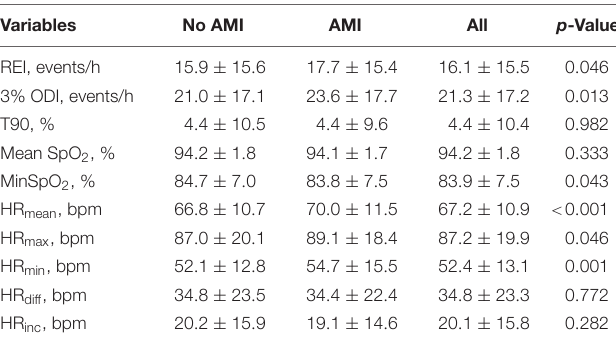
TABLE 2 | Sleep respiratory parameters and minSpO 2 -specific HR metrics among patients with and without